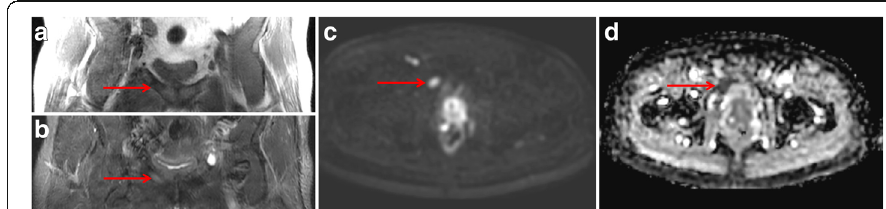
Fig. 3 Images of a 57 year old male with a two years history of prostate cancer (Gleason grade group 5, T2a, N1, M0), in androgen deprivation therapy, and referred for bone imaging due to increasing prostate specific antigen (NaF-PET/CT and WB-SPECT/CT images from the same patient are shown in Fig. 2). a - d Whole-body 3 T MR images demonstrate a lesion in the right superior pubic ramus detected on all four MRI sequences highly suspicious of a bone metastasis: ( a ) hypointense signal intensity on coronal T1w, ( b ) high signal intensity on coronal STIR, ( c ) high signal intensity on axial DWI b1000 and ( d ) low signal intensity on axial